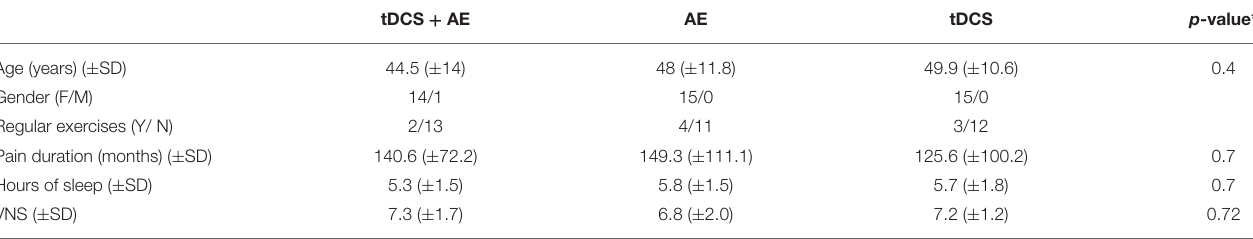
TABLE 1 | Sample data at baseline.